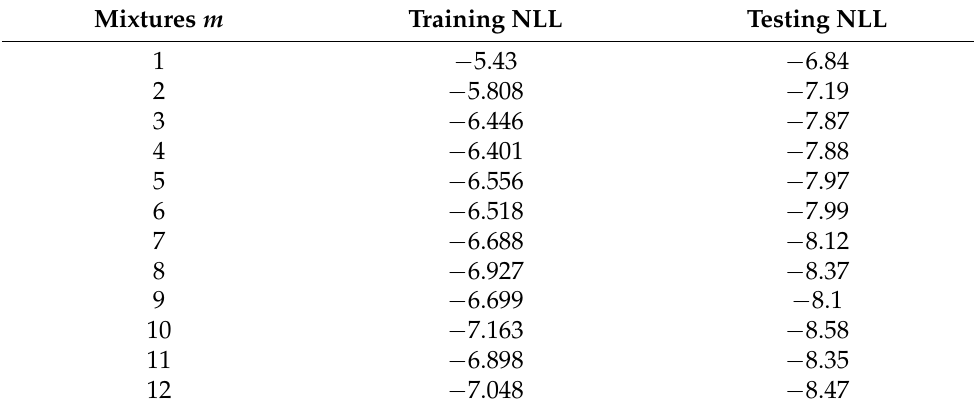
Table A1. Training, Testing and Validation NLL for Mixture m = 1 −